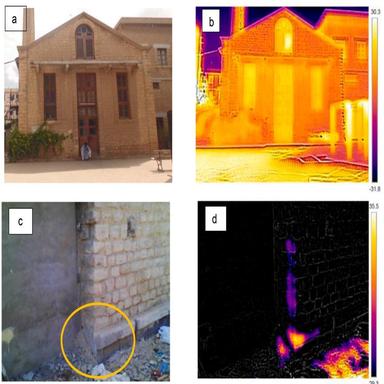
a) original W1 wall; b) thermal image of W1; c) original W3 wall; d) thermal image of W3.